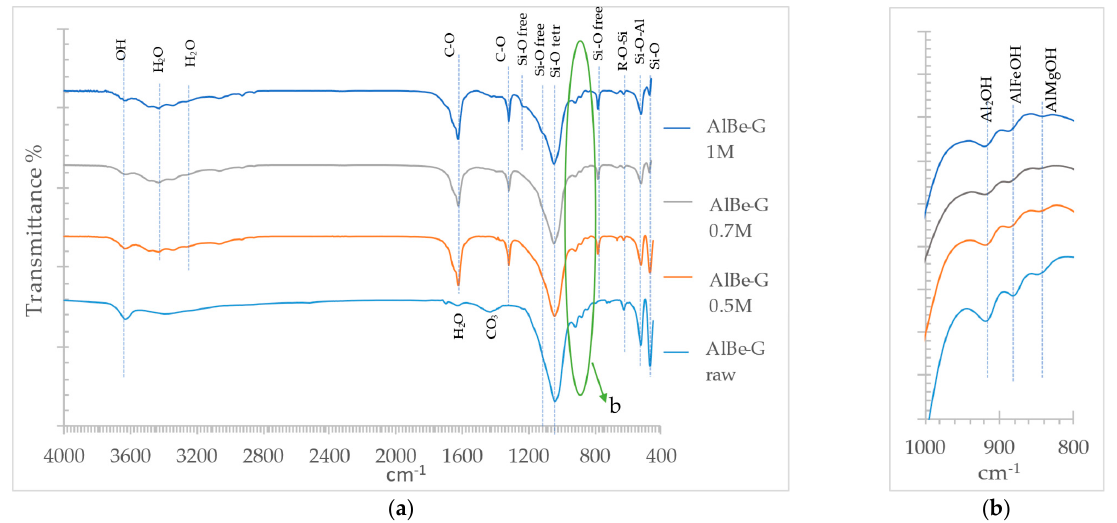
Figure 4. FT − IR spectra of AlBe-G samples (raw and activated with 0.5, 0.7 and 1 M oxalic acid). ( a ) Full spectra; ( b ) section 1000–800 cm − 1 .